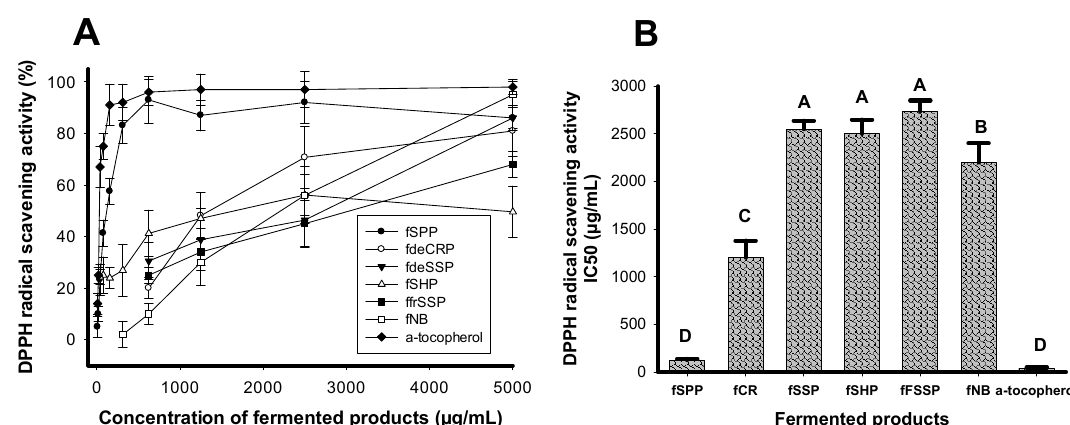
Figure 1. Antioxidant activity of CMs and nutrient broth fermented by Paenibacillus sp . TKU042. The culture supernatants were harvested after three days of fermentation. Tested antioxidant activity was then expressed as percentage ( A ) and IC 50 ( B ) values; least significant difference ( α = 0.1) = 300.77, coefficient of variation = 7.439375, triplicates for each experiment (n = 3), and means of IC 50 values with the same letter are not significantly different in comparison based on t-test ranking.